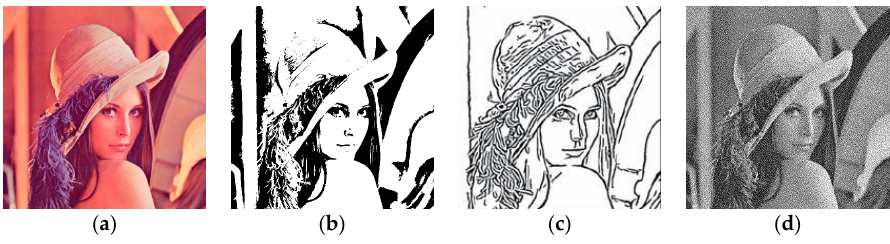
Figure 2. Different kinds of binary images. ( a ) input ( b ) thresholding ( c ) line drawing ( d ) halftone of Lena.